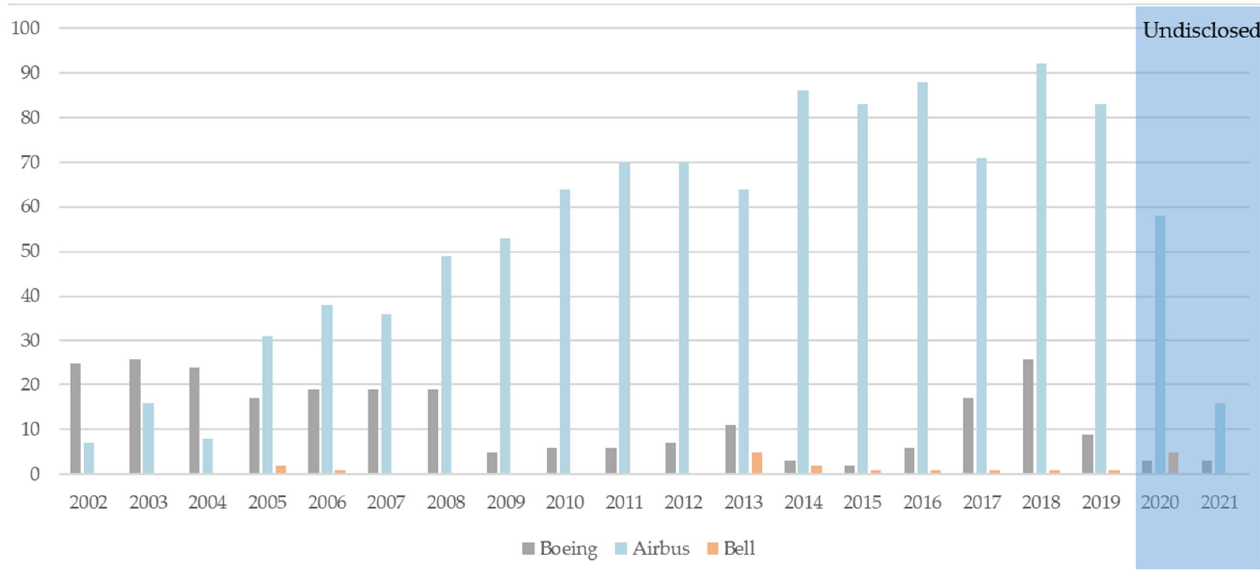
Figure 6. Time series analysis of 3 companies’ joint research.